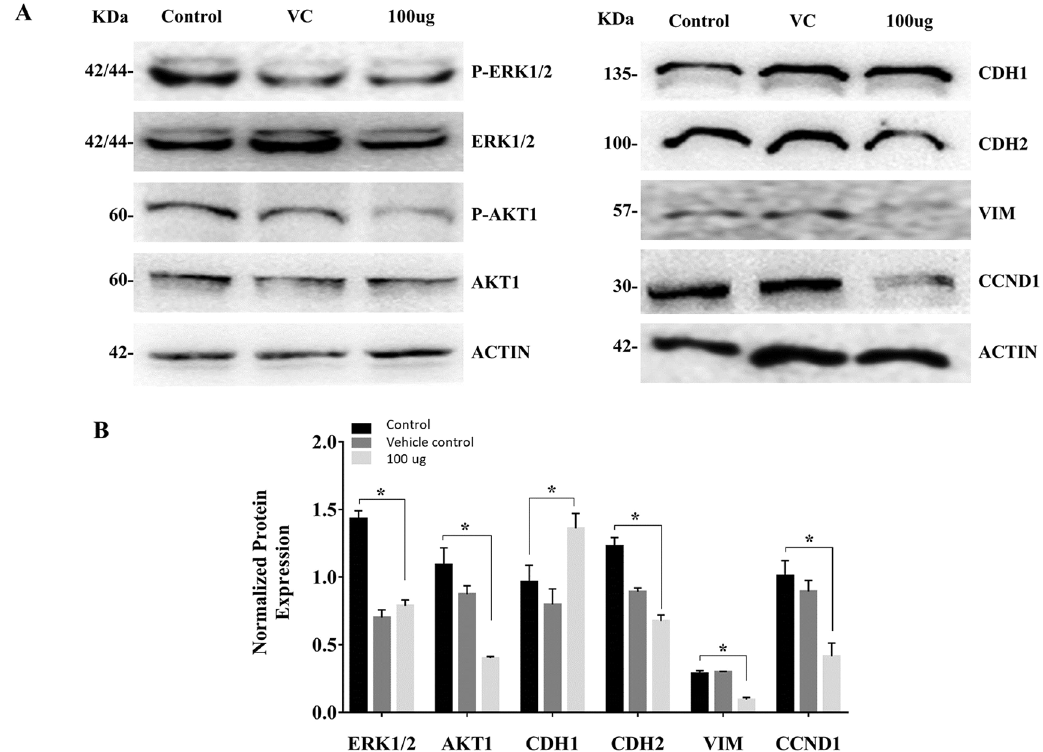
Figure 4. Effects of L. barbarum on ERK1/2, AKT1 phosphorylation, and EMT marker expression: (A) Representative westernblotimagesshowingreducedphosphorylationofERK1/2andAKT1upon L.barbarum extracttreatment.Higher CDH1 protein expression along with reduced levels of CDH2, VIM and CCND1 were observed when compared to the control in CAL-27 cells. (B) Bar graph showing normalized protein expression in treated and untreated groups. Densitometric analysis was performed using ImageJ software (http://imagej.nih.gov/ij/) using β -actin as an internal control (VC). The intensities of each bands were normalized with the corresponding β -actin band intensities. The normalized protein expression for ERK1/2 and AKT1 was represented as the ratio of phospho-protein to total